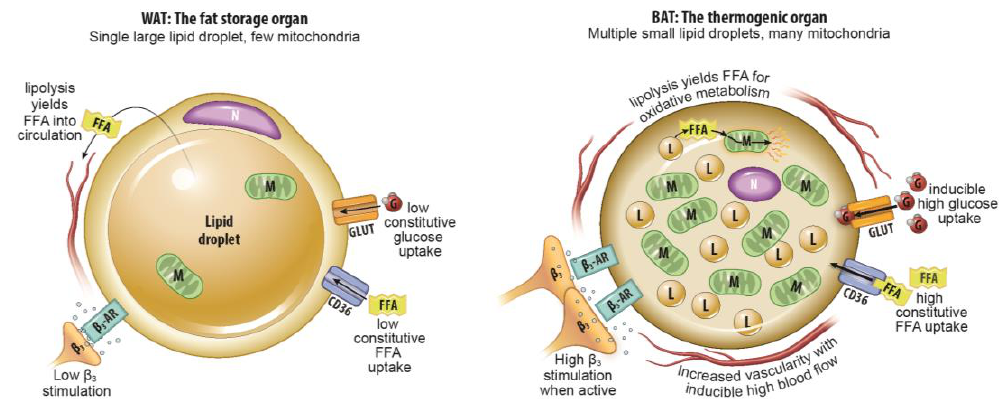
Figure 1. Summary of major physiological differences between white adipose tissue (WAT) and brown adipose tissue (BAT). A summary of major physiological differences relevant to imaging between WAT and BAT. FFA: free fatty acid, N: nucleus, M: mitochondria, β 3 -AR: beta-3 adrenergic receptor, G: glucose, L: lipid droplet, CD36: cluster of differentiation 36/fatty acid translocase, GLUT: glucose transporter .